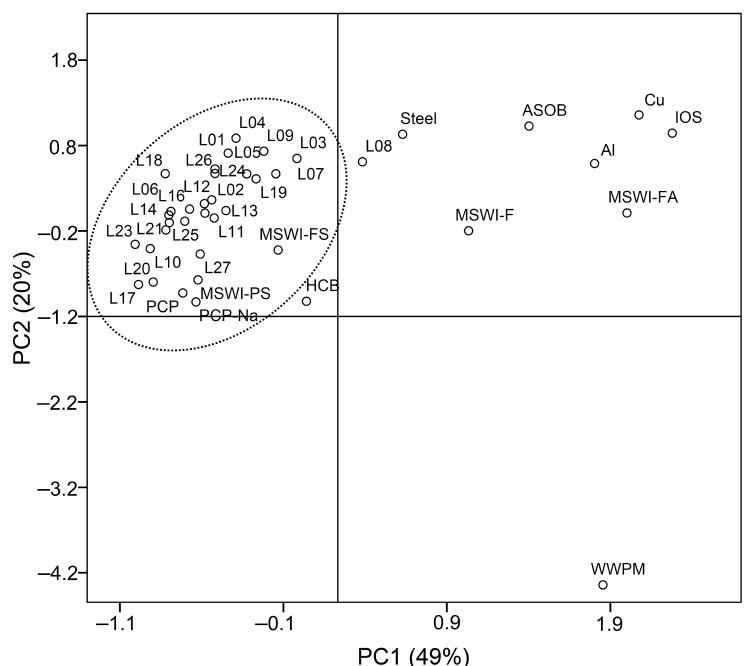
Figure 4. Principal component analysis (PCA) score plot of the 2,3,7,8-substituted PCDD/F con- geners in the sediments of LSR and the samples from the typical sources. Abbreviations: PCP, pentachlorophenol [44]; PCP-Na, sodium pentachlorophenate [44]; STEEL, ambient air around a steel plant [45]; Al, gaseous emission from secondary Al metallurgy [20]; Cu, gaseous emission from secondary Cu metallurgy [20]; IOS, gaseous emission from iron ore sintering plants [20]; MSWI-FS, fluvo-aquic soil near to a municipal solid waste incineration (MSWI) plant [46]; MSWI-PS, paddy soil near to a MSWI plant [46]; MSWI-F, flue gas from an MSWI plant [46]; MSWI-FA, fly ash from a MSWI plant [46]; WWPM, waste water from a pulp mill [47]; HCB, housecoal burning [48]; ASOB, agricultural straw open burning